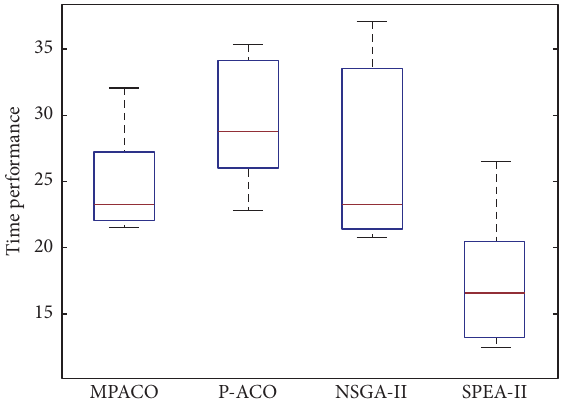
Figure 9: Boxplot of time performance on Scale 2 (in secs).